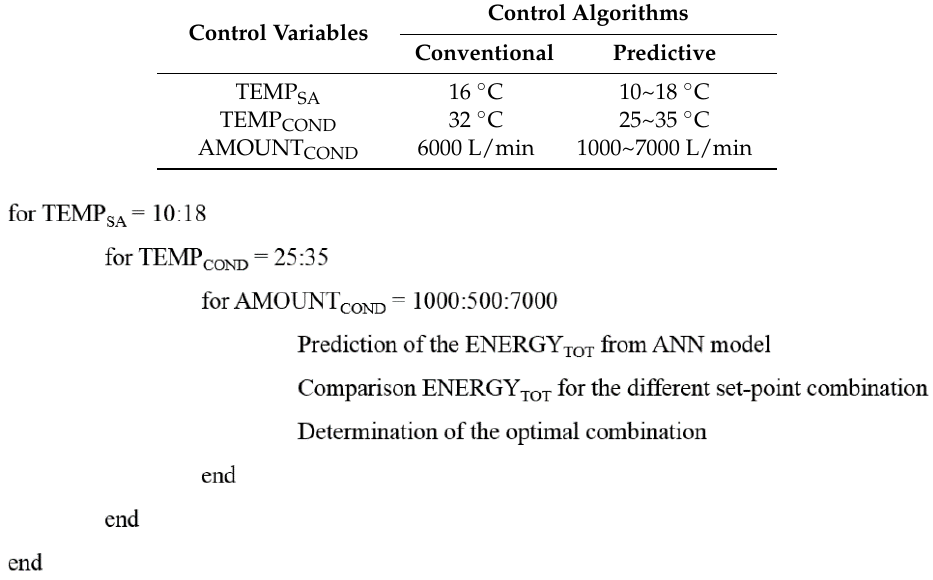
Figure 6. Structure of the programming code to determine the optimal set-points.